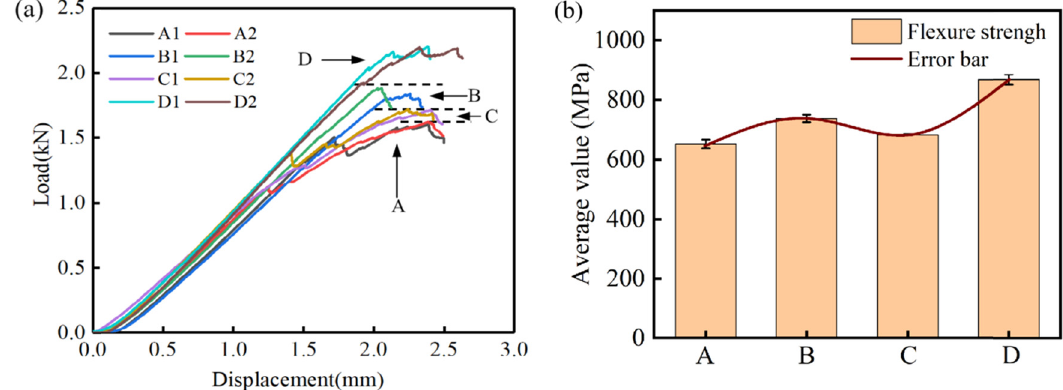
Figure 5: Bending test results for the four specimens: ( a ) load versus displacement, and ( b ) average fl exural